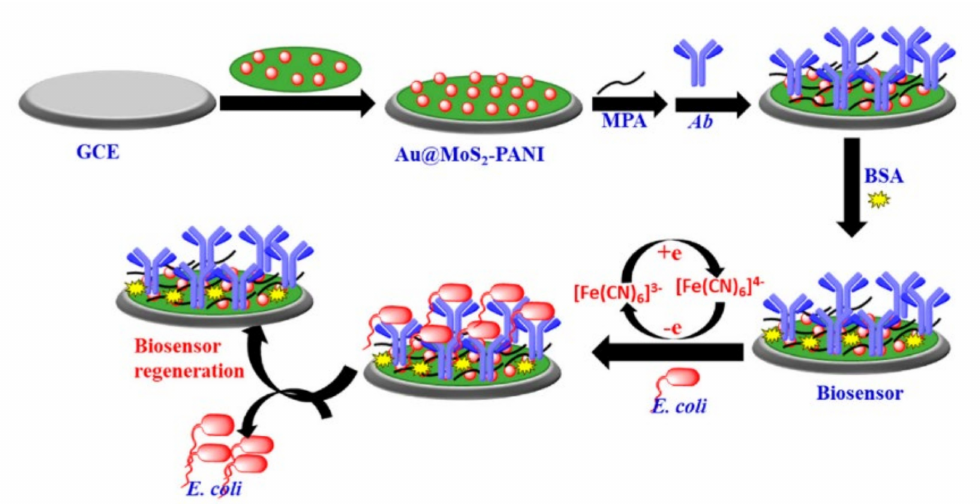
Figure 9. Schematic representation of the label-free electrochemical biosensor based on Au@MoS 2 – PANI. Adapted with permission from [128] Copyright 2021,